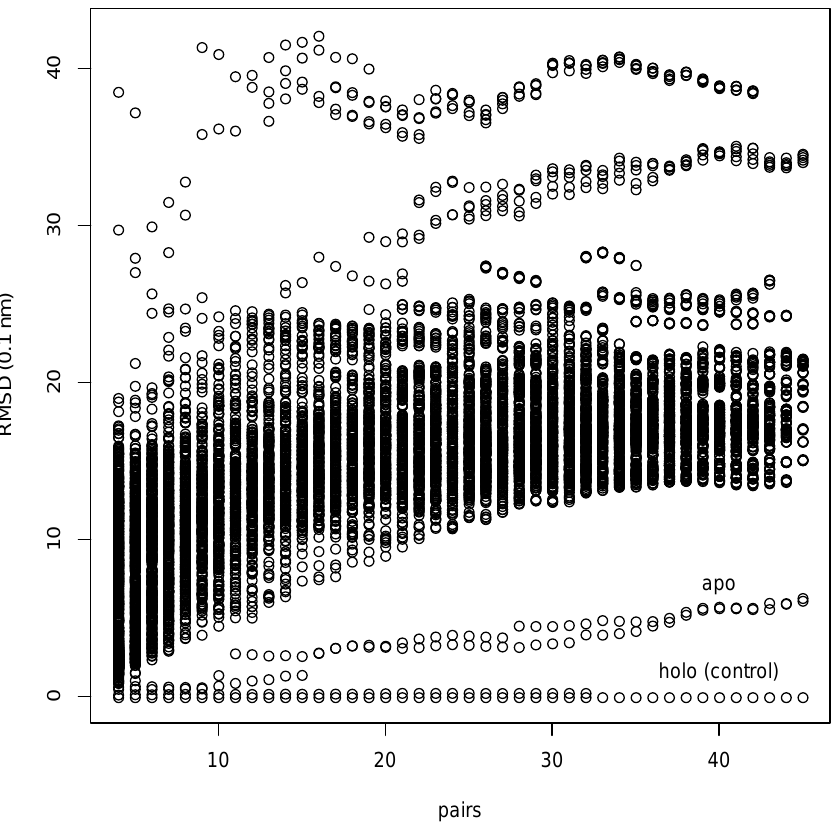
Figure 8. Search for an epitope in a database [16]. 86 structures of different apo-enzymes are searched for a match with a ligand binding pocket of 45 amino-acids. The source of the query epitope (1AKE) is included as control. The method identifies amongst the structures the one correct apo-structure (4AKE) as match with lowest RMSD